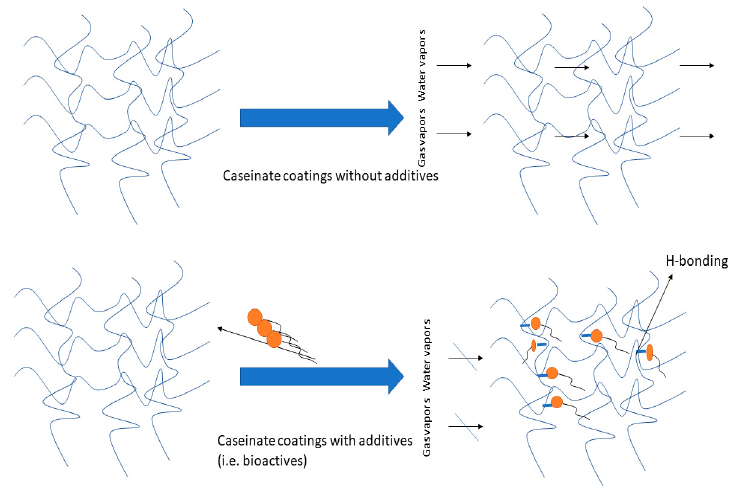
Figure 5. Influence of additives on physicochemical properties of active casein